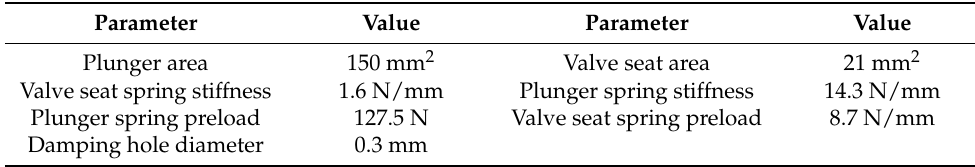
Table 2. Cushion valve key component